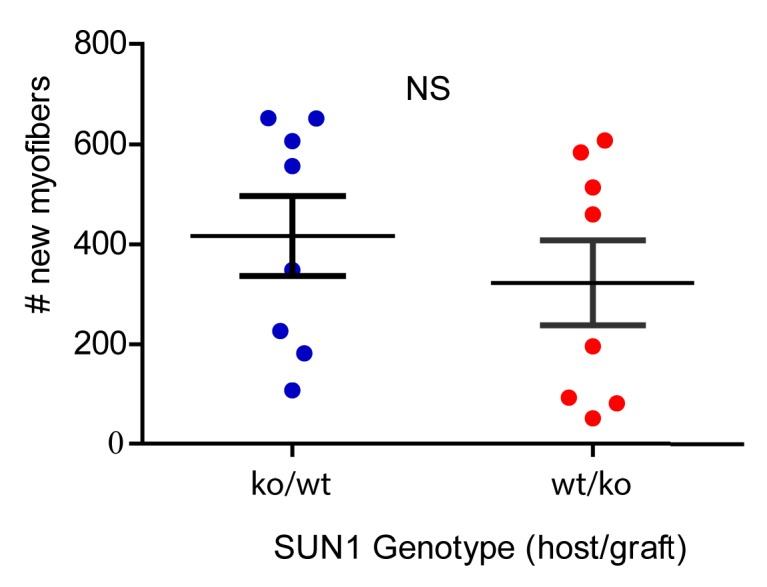
Number of regenerated myofibers in reciprocal graft transplants; WT EDL into Sun1–/– host (ko/wt) and Sun1–/– EDL into WT host (wt/ko) reveals no significant differences.